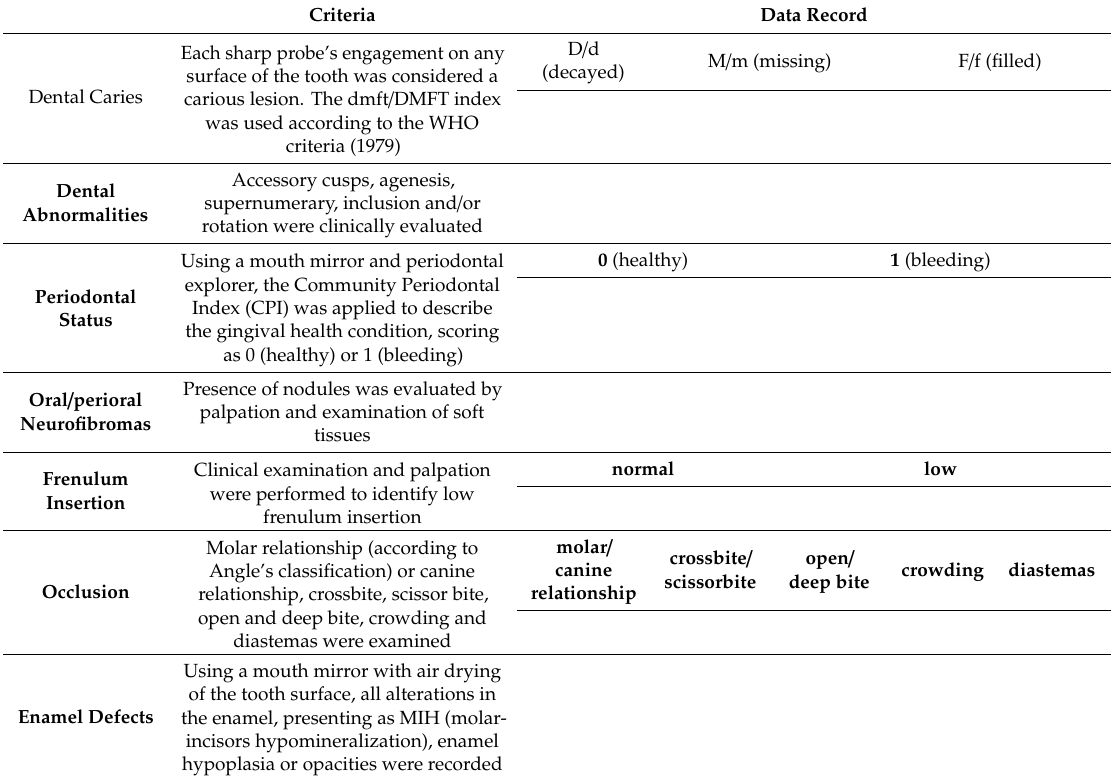
Table 1. Intraoral examination chart of standardized protocol.